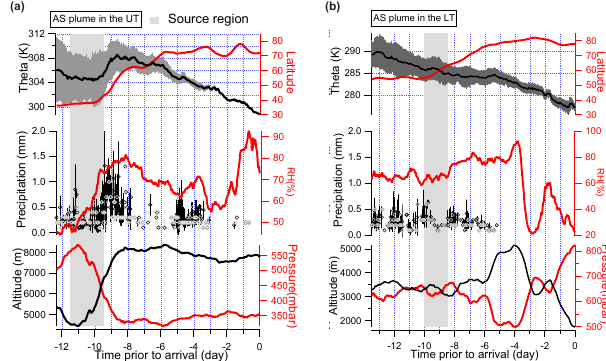
Figure 8. Vertical profiles (binned in 200m altitude) and plumes classified by air mass origin: the lines show the mean values and + σ (standard deviation) for data obtained during vertical profiles; the filled markers denote values derived during plume intercepts along straight and level runs for (a) rBC mass loading; (b) (cid:49) CO; (c) sul- phate and organic matter. Note there were no sulphate or organic data available for AS vertical profiles therefore only AS plume in- formation is shown in panel (c) . The horizontal dash lines on each graph show the bounds of LT/MT/UT.